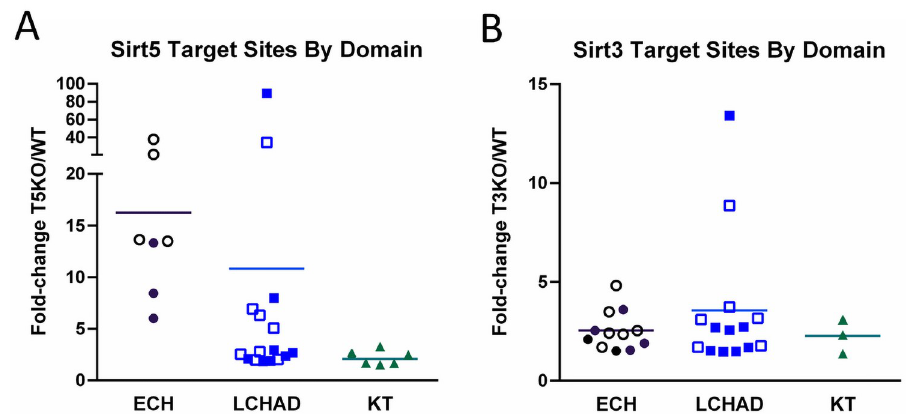
Fig 1. Distribution of known Sirt5 and Sirt3 target sites across the three enzymatic domains of TFP. A) Sirt5 target sites taken from Rardin et al. [6], categorized by location to either the enoyl-CoA hydratase (ECH) of TFP α , the long- chain 3-hydroxyacyl-CoA dehydrogenase (LCHAD) domain of TFP α , or the ketothiolase domain (KT) encoded by TFP β . B) Sirt3 target sites taken from Hirschey et al. [7] and categorized by TFP enzymatic domain. In both panels the horizontal lines represent the mean fold-change (KO/WT) and open symbols represent sites important for substrate channeling within the TFP complex, determined by the recently published TFP crystal structure [19].